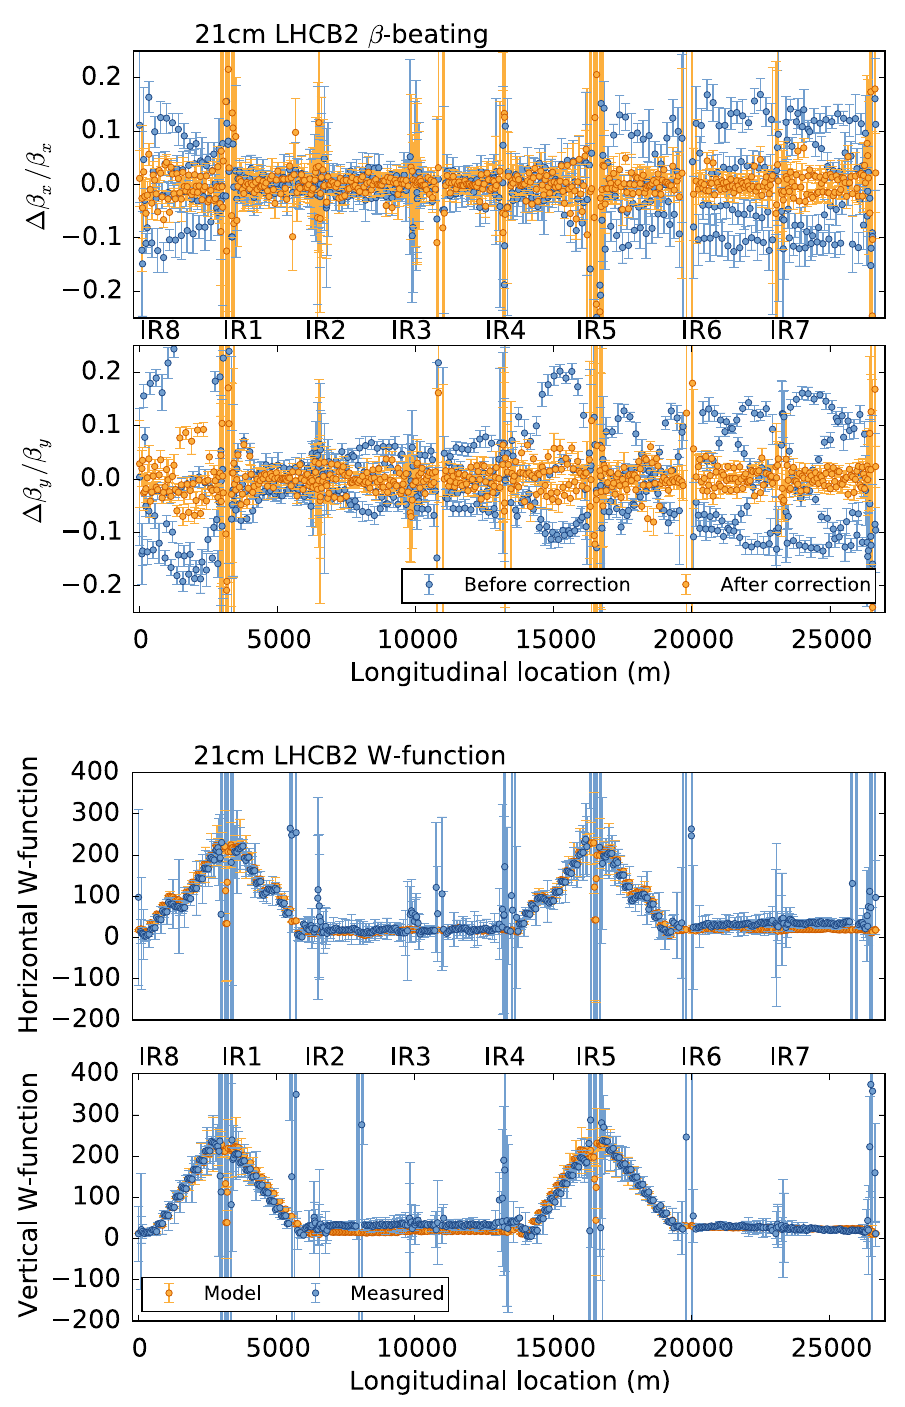
FIG. 5. 2016 ATS MD: β -beating (H/V) for Beam 2 at β (cid:1) ¼ 21 cm ( r Tele ≈ 2 ) before and after correction (top), and corresponding chromatic functions